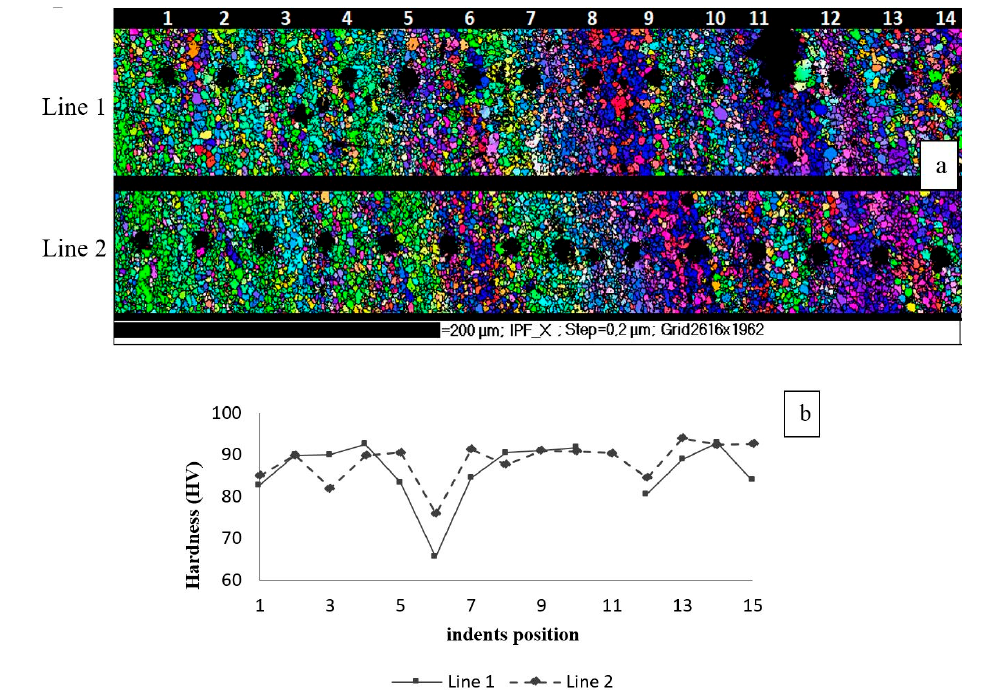
Figure 7. IPF contour maps of Figure 6 representing ( a ) BM, ( b ) Area I, ( c ) Area II, ( d ) Area III, and ( e )